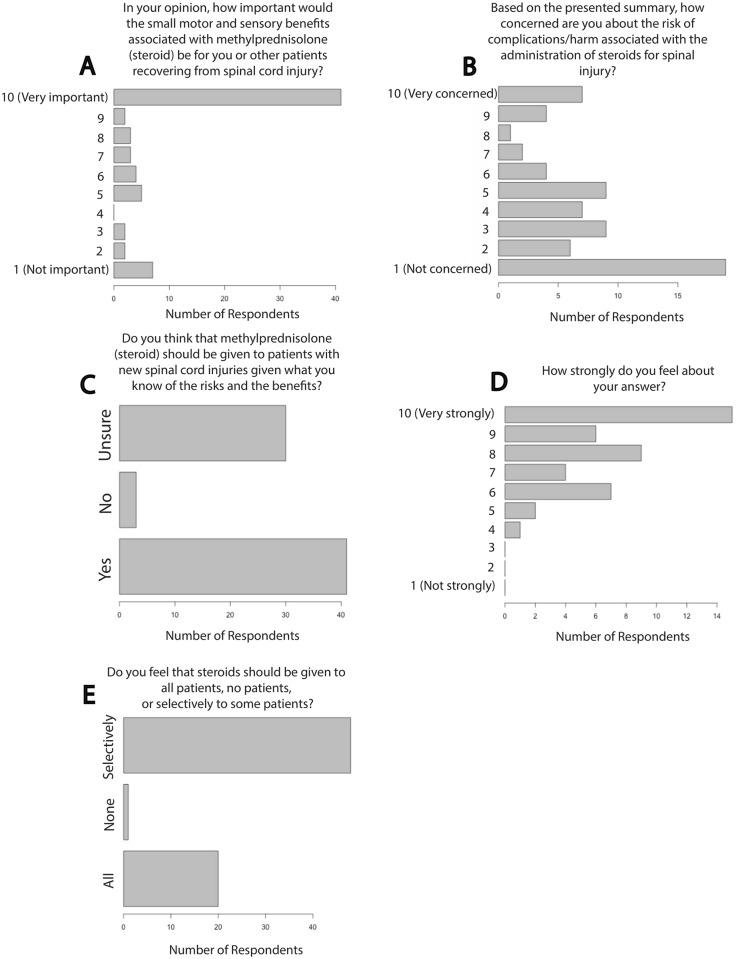
Chronic SCI Patients Favor Administration of Methylprednisolone for Acute SCI.Patient responses to survey questions related to MPSS use for acute SCI are shown. Chi-square testing revealed that responses to all questions differed significantly from expected responses in which all possible answers would have been selected with equal frequency. The sample size for (A), (B), (C), (D) and (E) were 69, 68, 74, 69 and 44 respectively. MPSS = methylprednisolone sodium succinate, SCI = spinal cord injury.